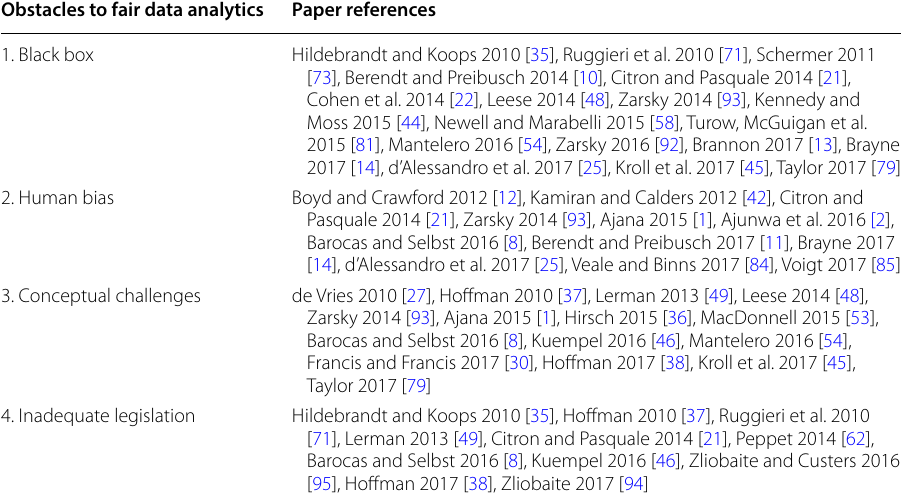
Table 6 Barriers to fair data analytics Obstacles to fair data